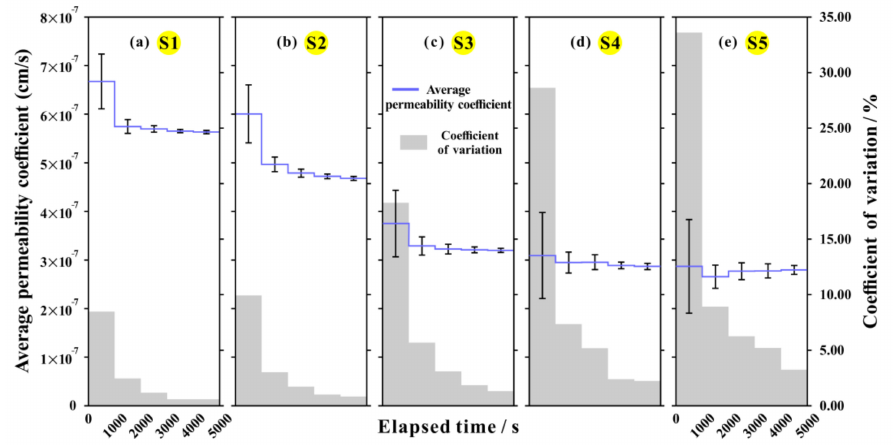
Figure 5. Average value and coefficient of variation of S1–S5 permeability coefficient (per 1000 s).